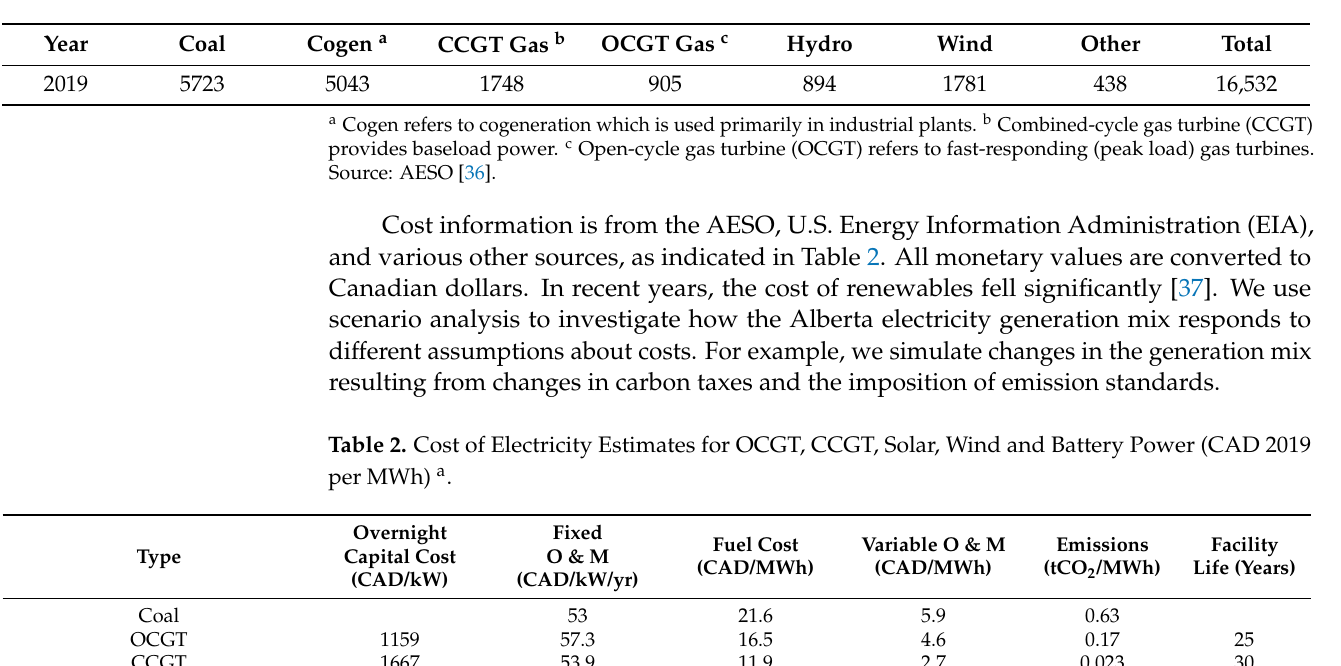
Figure 3. Load duration curve in 2019 in Alberta. Table 1. Alberta Electric System Generating Capacity in 2019 (MW).